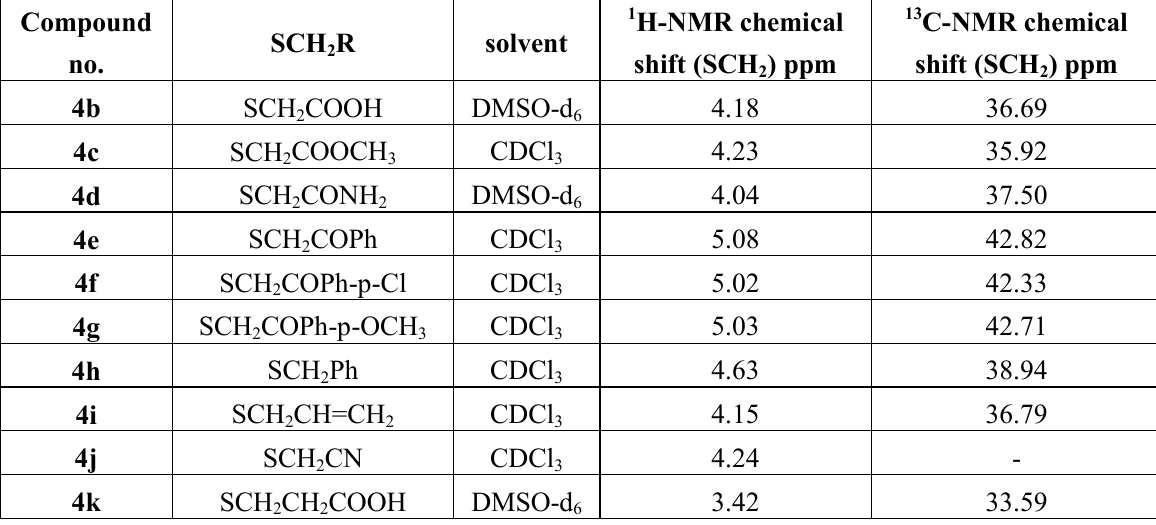
Table 4. 1 H NMR and 13 C NMR chemical shifts for the SCH S-alkylated derivatives 4b -